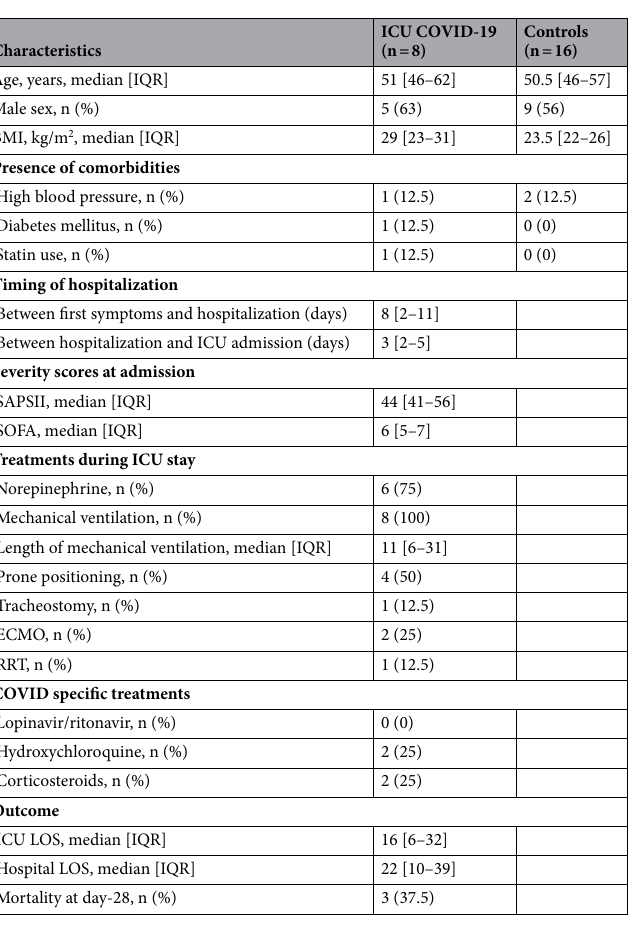
Table 1. General characteristics and outcome of ICU COVID-19 patients and control subjects. BMI, body mass index; ECMO, extracorporeal membrane oxygenation; LOS, length of stay; RRT, renal replacement therapy; SAPS II, simplified acute physiology score